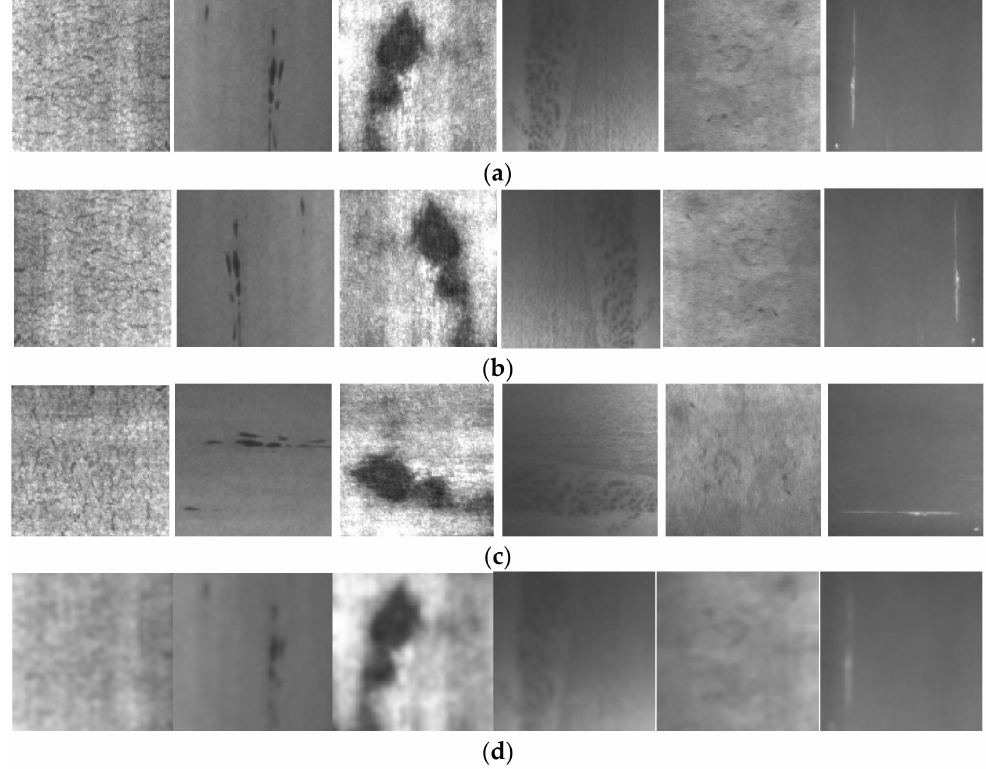
Figure 6. Example images after data augmentation: ( a ) the original images, ( b ) images after flipping 180 ◦ , ( c ) images after flipping 90 ◦ , and ( d ) images after adding Gaussian noise (radius = 3).